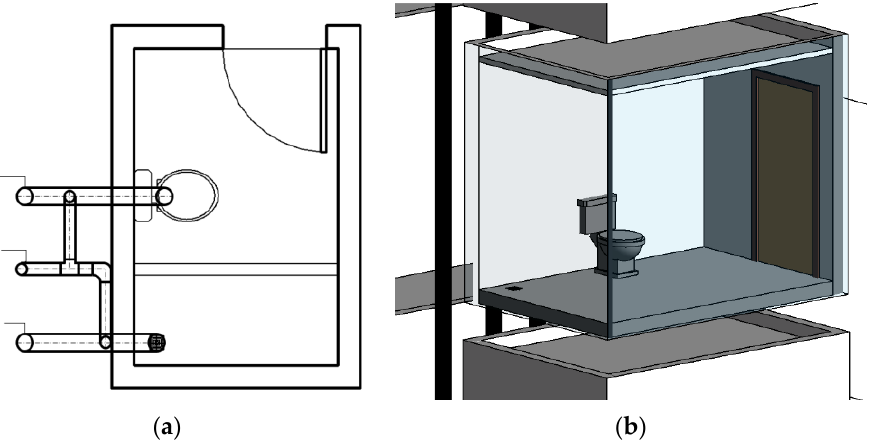
Figure 4. Simulation model unit design including unit opening and pipelines. ( a ) Simulation unit floor plan. ( b ) Bathroom unit perspective drawing.